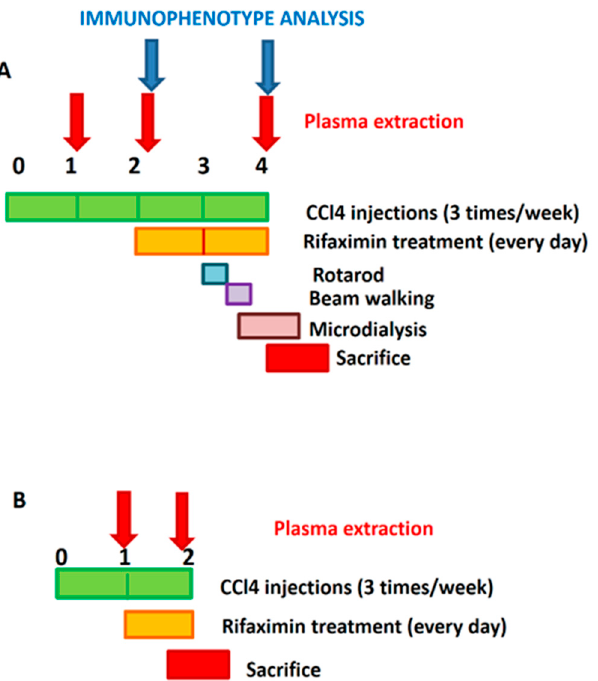
Figure 1. Experimental design. ( A ) In most experiments, treatment with rifaximin started 2 weeks after the first CCl 4 injection and was maintained daily until sacrifice, at the end of the fourth week. Blood from saphenous vein was taken at 1, 2, and 4 weeks for analysis of plasma cytokines and at 2 and 4 weeks for immunophenotype analysis. Motor coordination was assessed at the beginning of the fourth week. In vivo microdialysis was performed at 4 weeks. ( B ) To analyze effects of rifaximin on initial alterations, some experiments were carried out starting treatment 1 week after the first administration of CCl 4 . Daily treatment with rifaximin started at the beginning of the second week and maintained during the entire week. Rats were sacrificed at the end of the second week. Blood was taken for analysis of plasma cytokines at the beginning of the first and end of the second week.